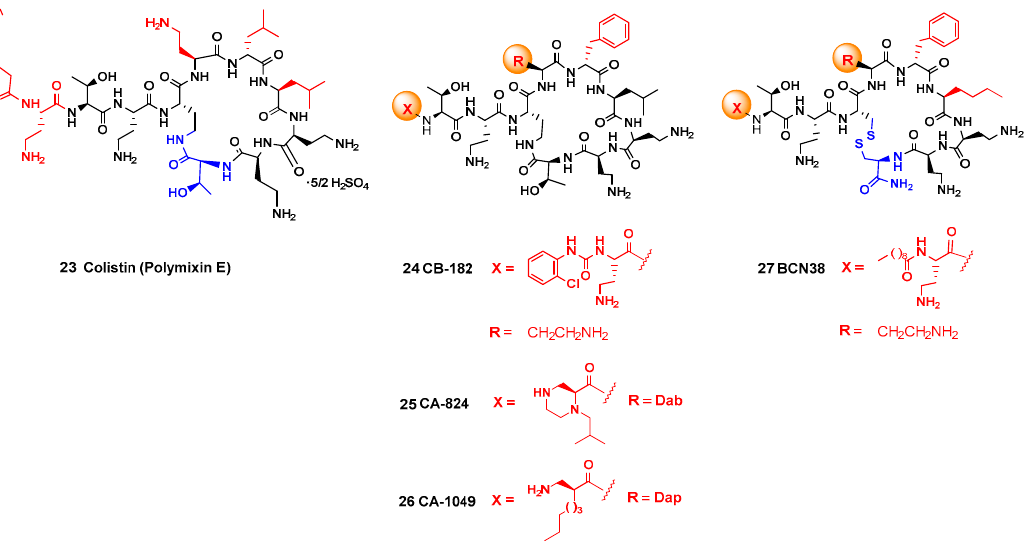
Figure 2. Structures of colistin A, its analog CB-182,804, the Cantab analogs CA-824 and CA-1049, and the Barcelona disulfide analogs. The positions were changes were made are displayed in colors.